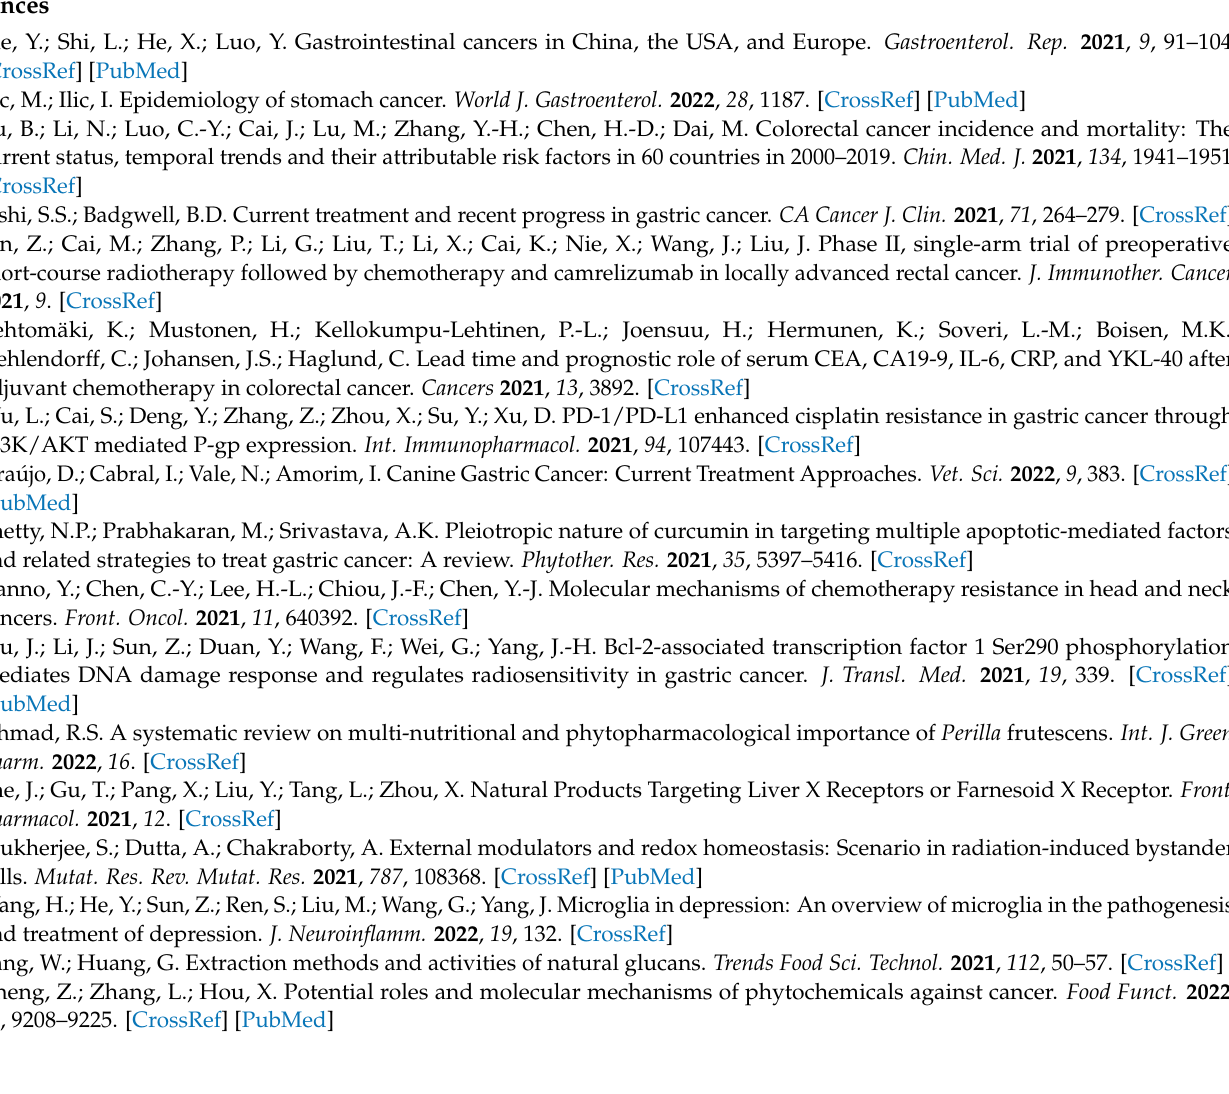
viability. Figure S2: The results of electrophoresis. The real-time PCR products were loaded on 1% agarose gel and detected using a transilluminator (Jal Doc,